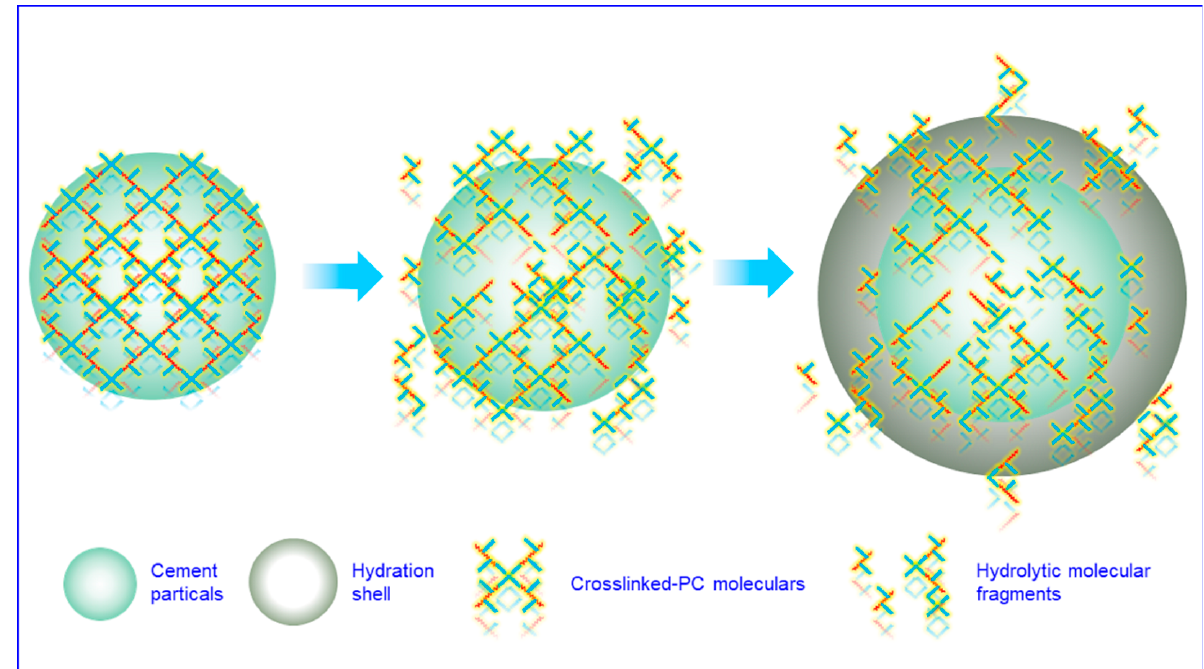
Figure 5. Schematic representation of the dispersion and adsorption behaviors of crosslinked-PC on cement particles.